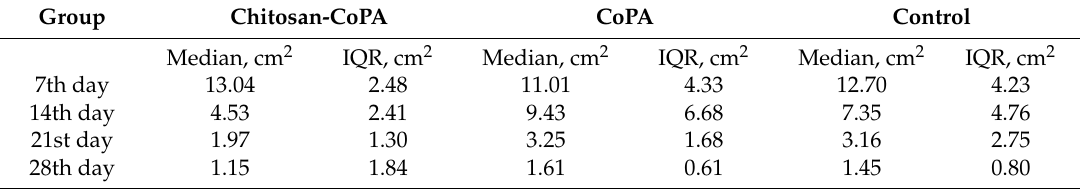
Figure 5. Box-plot of planimetric assessment data of wound surface area after different periods of observation. Table 1. Surface area planimetric assessment data, including medians and interquartile ranges.